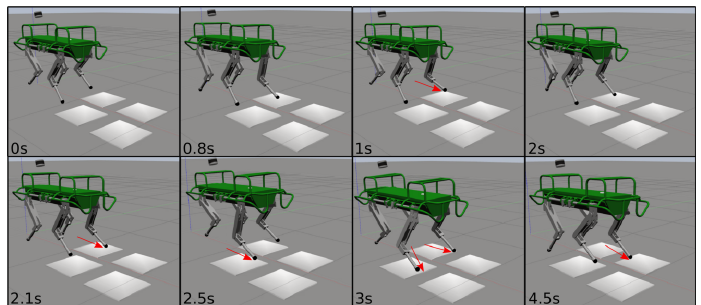
Figure 8. Simulation of the HyQ robot traversing slippery terrain patches with a trot gait (low friction patches illustrated in white). The image sequence starts from the top left to right and continues at the bottom left. The red arrows indicate slipping feet.